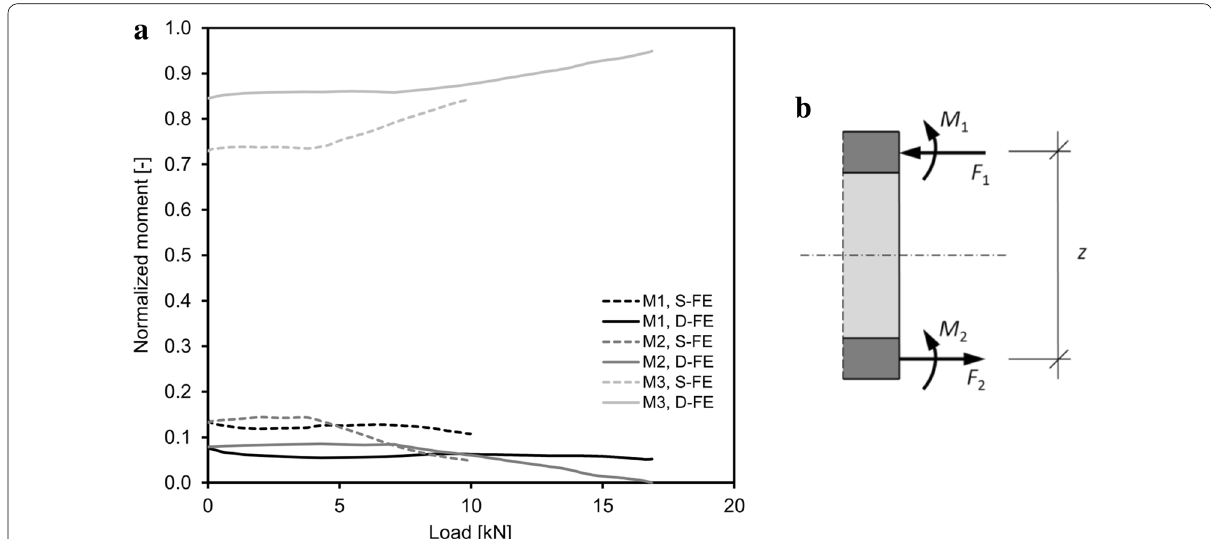
Fig. 18 a Distribution of section moment components ( M 1 , M 2 and M 3 ) evaluated from FE-analyses and b illustration of internal section